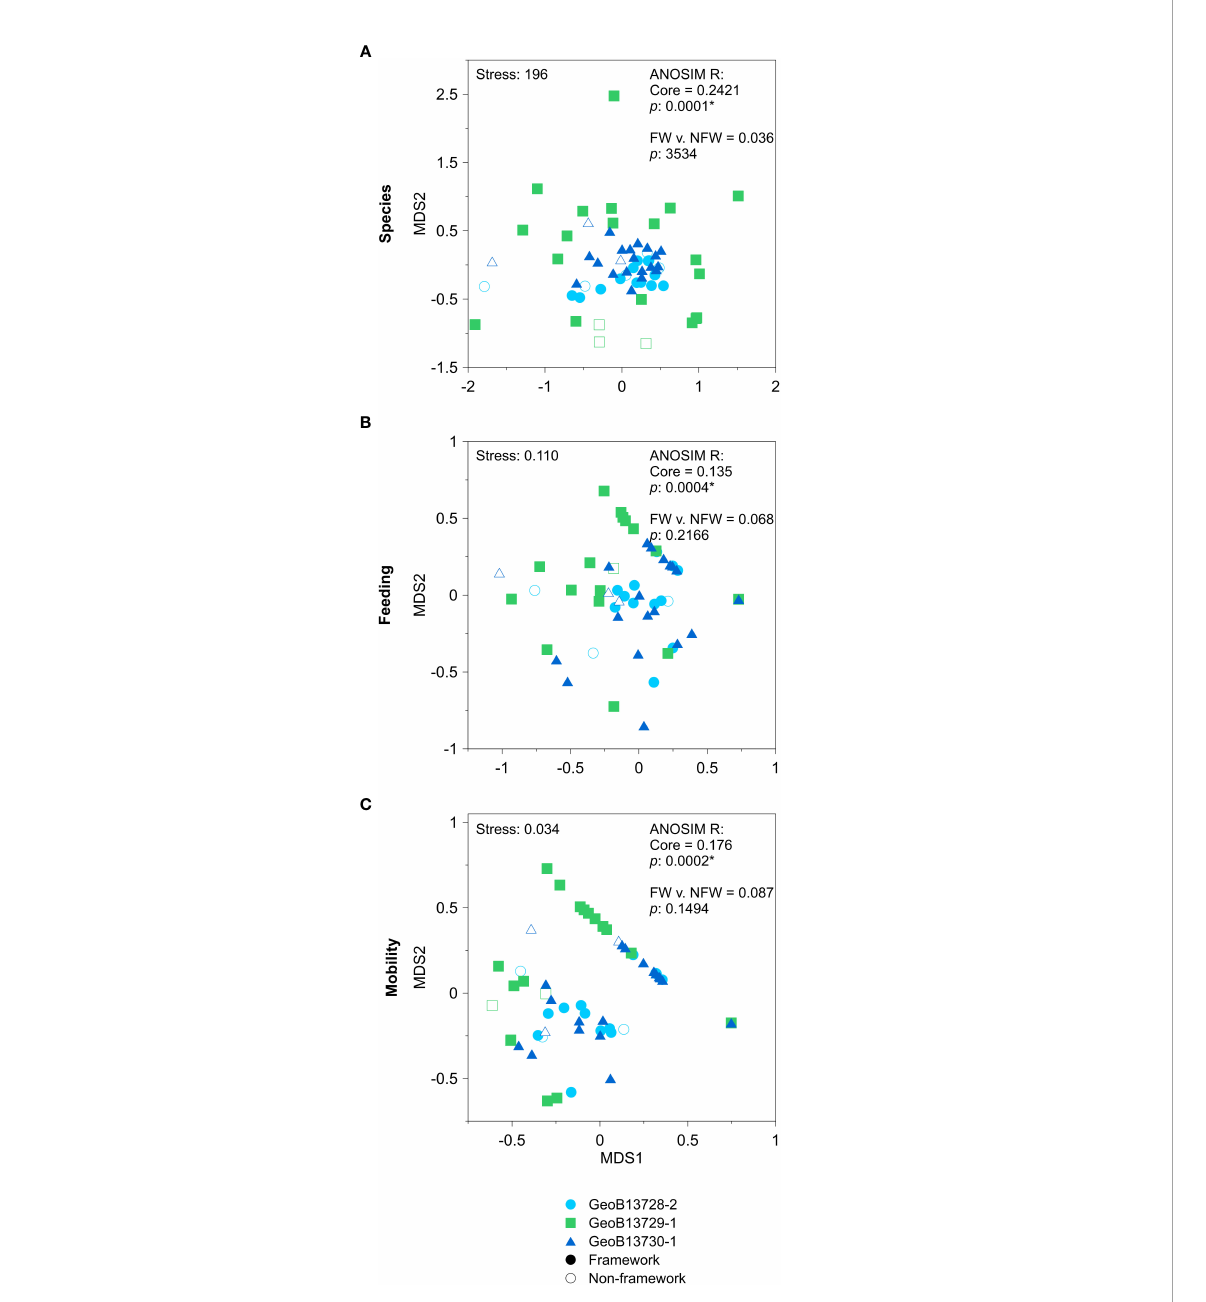
FIGURE 5 Non-parametric multi-dimensional (nMDS) scaling plots of all molluscan assemblages from all cores for (A) species, (B) feeding, and (C) mobility groups. ANOSIM R and p -values for analyses testing for differences between cores (Cores) and between assemblages associated with intervals of coral framework versus non-framework (FW vs. NFW) are provided within each relevant